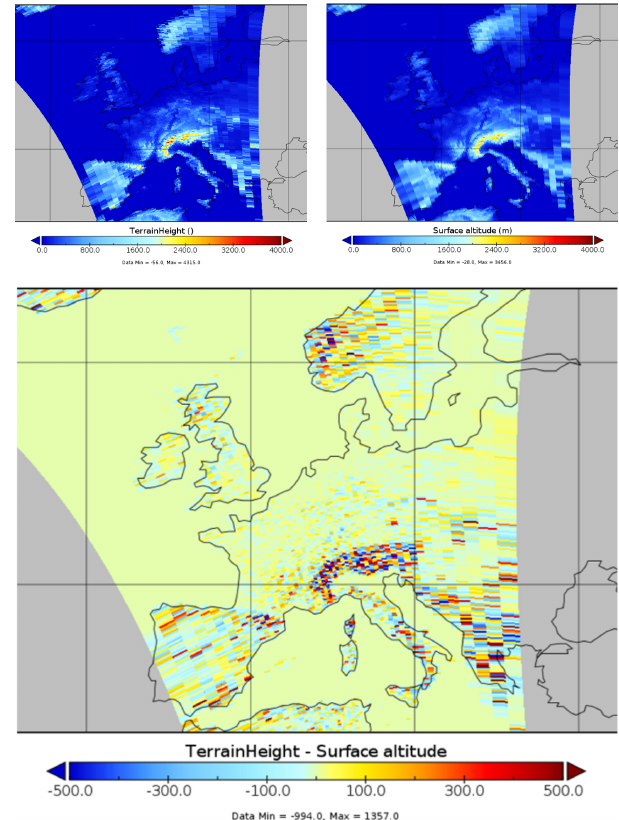
Figure 20. The top left panel shows the terrain height for orbit 84291 in the collection-3 product. The top right panel shows the same for the collection-4 product. The bottom panel shows the dif- ference; especially in mountainous areas, such as Norway and the Alps, the differences are clearly